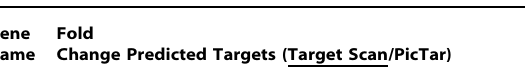
Table 2. Differentially expressed miRNAs in ovarian cancer tissues and cell